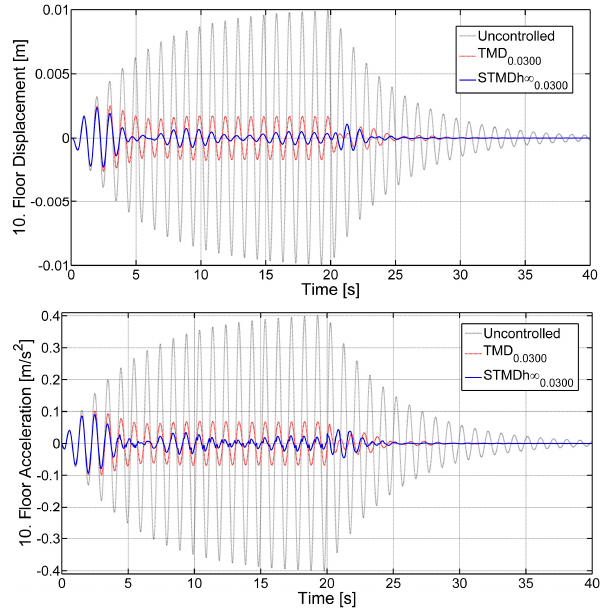
Figure 8. The TMD (cid:2868).(cid:2868)(cid:2871)(cid:2868)(cid:2868) and the STMDh∞ (cid:2868).(cid:2868)(cid:2871)(cid:2868)(cid:2868) the displacements (top) and accelerations (bottom) Figure 8. The TMD 0.0300 and the STMDh ∞ 0.0300 the displacements (top) and accelerations (bottom) under the Excitation-1 force. under the Excitation-1